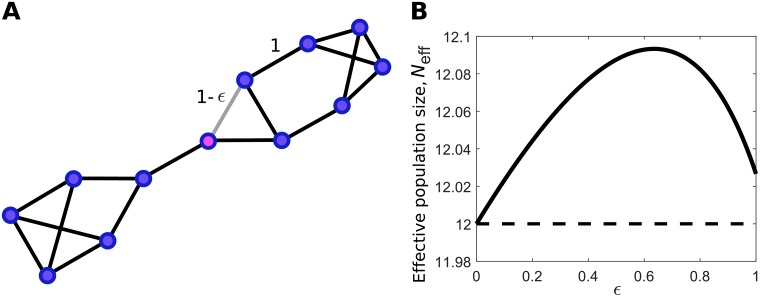
Creating an amplifier of weak selection for death-Birth updating.(A) We begin with a 3-regular graph of size 12 in which all edges have weight 1. This graph is isothermal, and therefore has Neff = N = 12. We solve for remeeting times according to Eqs (5) and (6), and identify the vertex with the largest remeeting time (τi ≈ 18.29, shown in magenta). We decrease the edge weight from this vertex to one of its neighbors by an amount ϵ. (B) As this edge weight decreases, the graph becomes an amplifier of weak selection (Neff > N). For ϵ = 1, the resulting undirected, unweighted graph is still an amplifier of weak selection, with effective population size Neff ≈ 12.03.